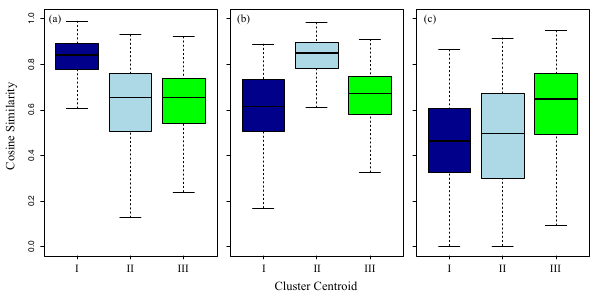
Fig. 4. Spectrum similarity to cluster I centroid (dark blue), cluster II centroid (light blue), and cluster III centroid (green) for (a) clus- ter I spectra, (b) cluster II spectra, and (c) cluster III spectra. The horizontal bar in each box represents the median value. Each box’s upper and lower bounds represent the 25th and the 75th percentiles, respectively; the whiskers extend to 1.5 interquartile